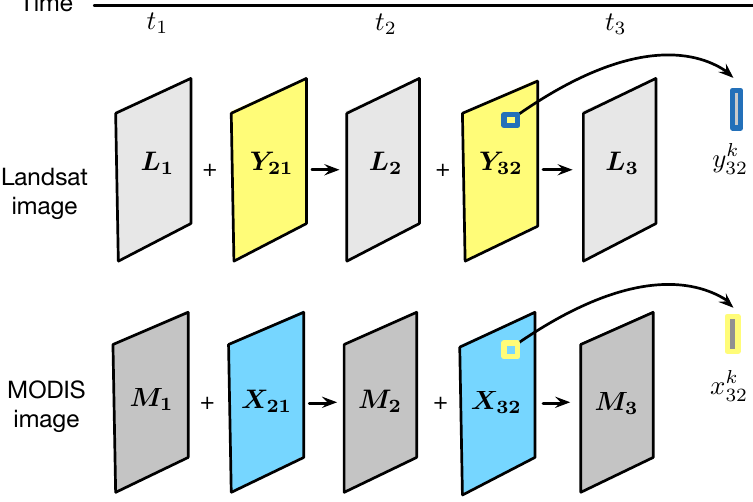
Figure 4. Block diagram of the spatio-temporal fusion proposed in Huang and Song